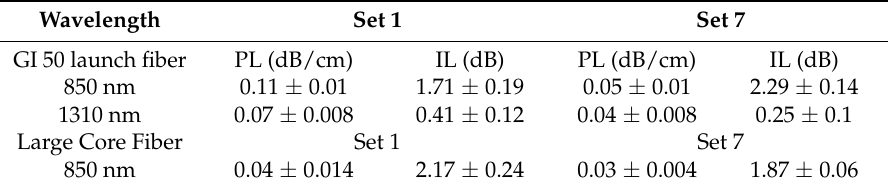
Figure 9. Cut-back measurements on both glass waveguide samples under test to compare end facet coupling losses at both 1310 nm and 850 nm with a standard fiber launch and 1310 nm only with a large core fiber (200 μ m) launch in accordance with IEC measurement standard [11]. Table 1. Derivation of Insertion Loss (IL) and Propagation Loss (PL) from cut-back measurements. Wavelength Set